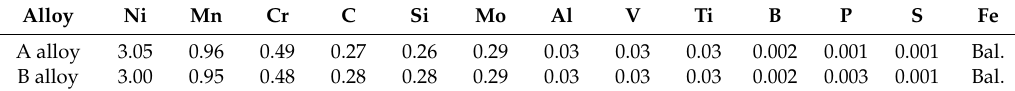
Table 1. Chemical compositions of alloys A & B used in this study (in wt. %).